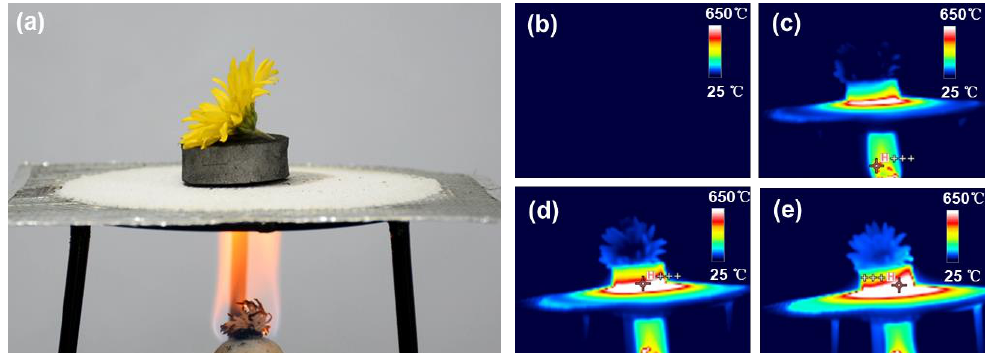
Figure 5. Experiment investigation of GSA-10 thermal insulation under fire-heating conditions. ( a ) Experiment setup for GSA. Fresh flower was placed over a flame over its top side. ( b – e ) Temperature distribution for GSAs and entire configuration changes of flower after different heating times, including initial status, and 10, 20, and 30 min, respectively.